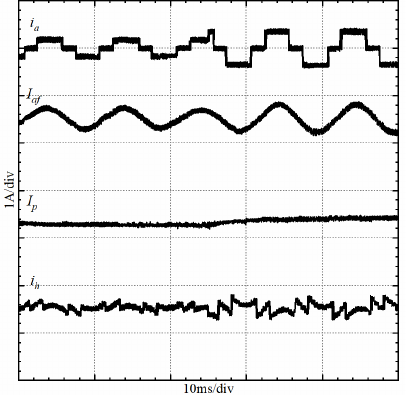
Figure 7. Experimental diagram of fixed-step adaptive filter.